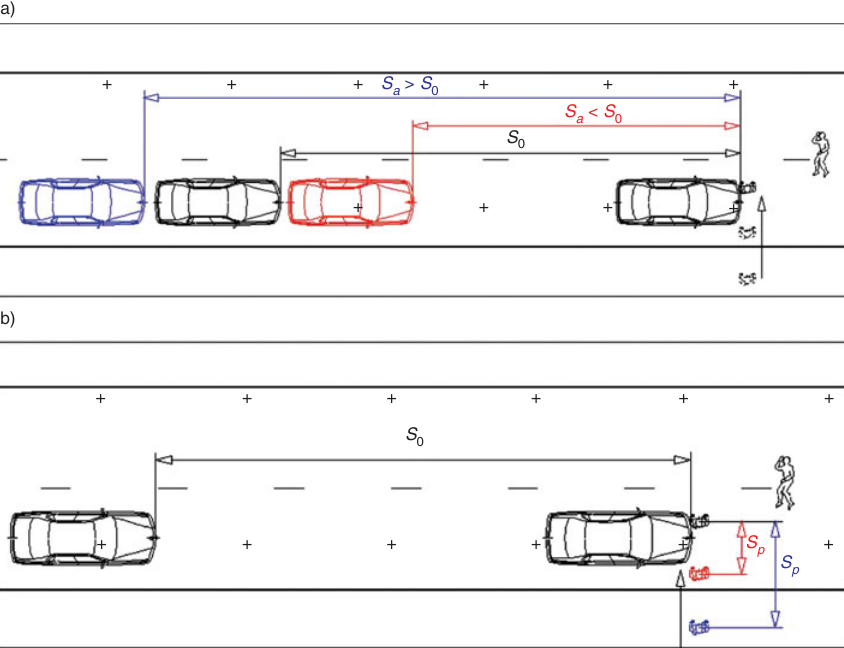
Fig. 7. The methods for determining the availability of technical possibility for the driver to avoid the pedestrian accident: a (cid:2) through the comparison of distance S a (the distance between the motor vehicle and the location of the pedestrian hitting at the moment, when a threat to traffic safety occurred) with distance S 0 (the braking distance); b (cid:2) through the reconstruction and assessment of the traffic situation at the moment when the motor vehicle was away from the